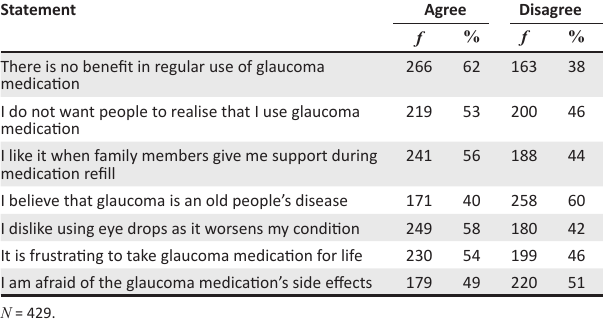
TABLE 3: Participants’ attitude and beliefs towards glaucoma disease.